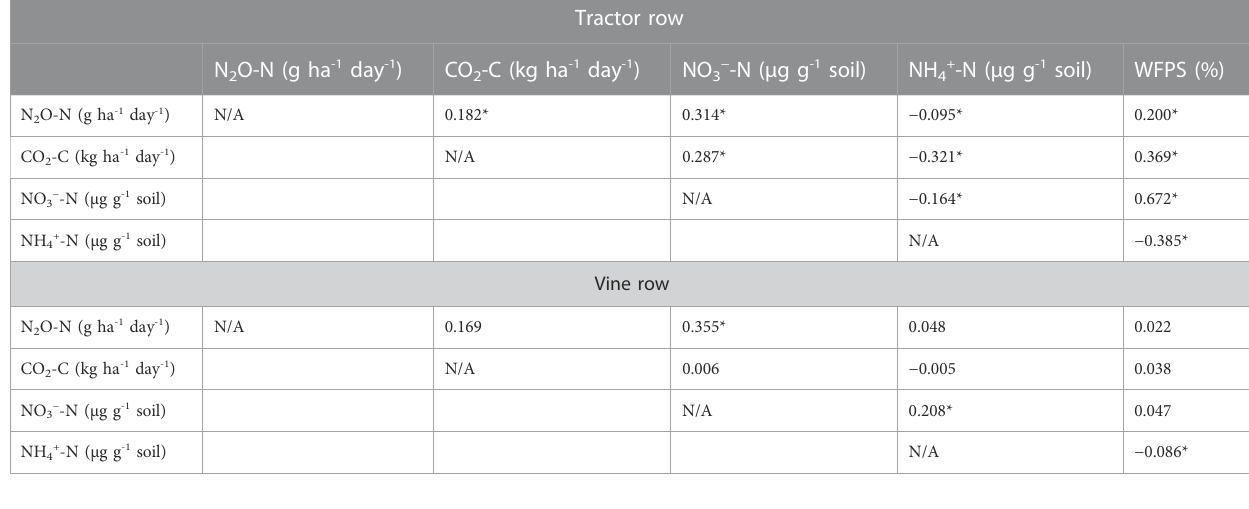
TABLE4Non-parametricSpearmancorrelationtestonN 2 Odaily fl uxvs.water- fi lledporespace(WFPS),soilmineralnitrogenconcentrations(NH 4 + -NandNO 3 − -N), and CO 2 daily fl ux by functional locations in October 2018 — March 2020. Asterisks (*) indicate the signi fi cant correlations at p < 0.05.